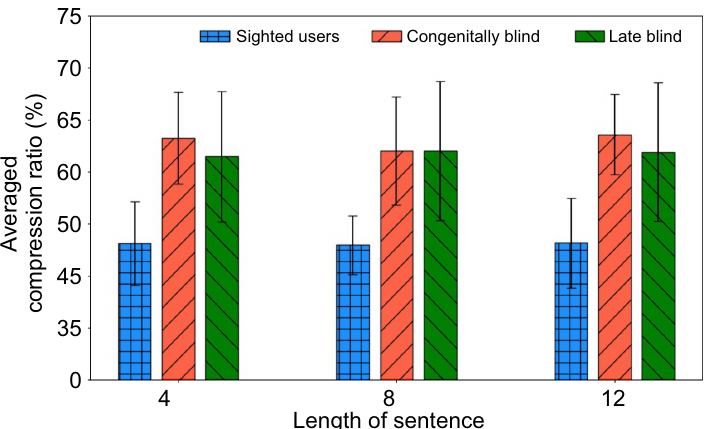
Figure 5. Mean performance obtained by three participant groups as a function of auditory sensitivity. The values of the bar charts indicate the average scores of the tests for each level. Error bars indicate standard errors of the